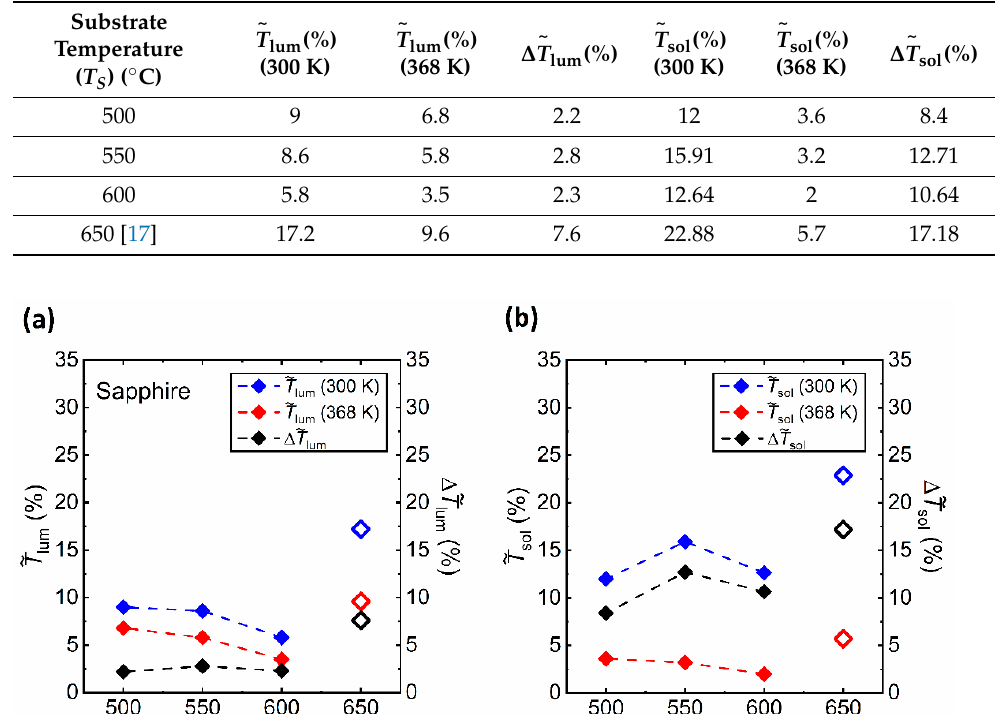
Table 4. Luminous and solar modulation efficiencies of VO 2 films prepared on sapphire substrates at various T S .